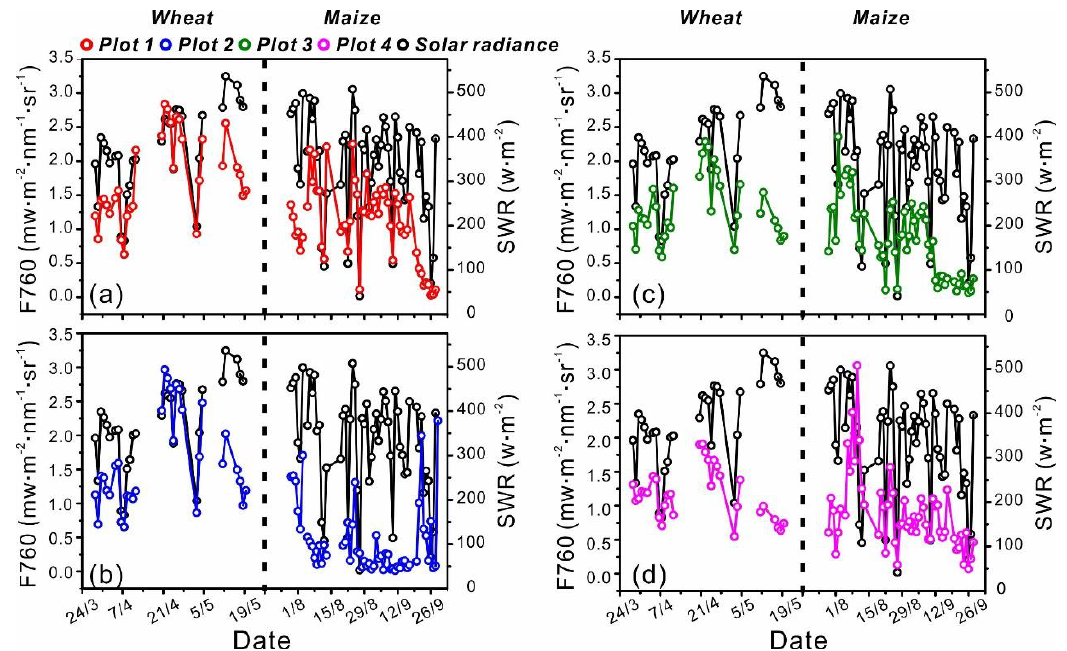
Figure 3. Seasonal patterns of daily F760 from wheat (left of dashed line) and maize (right of dashed line) in the four plots compared with daily solar radiation (SWR). All measurements of wheat were collected from 28 March to 19 May 2017, while the measurements of maize were collected from July 29 to September 29 of 2017.